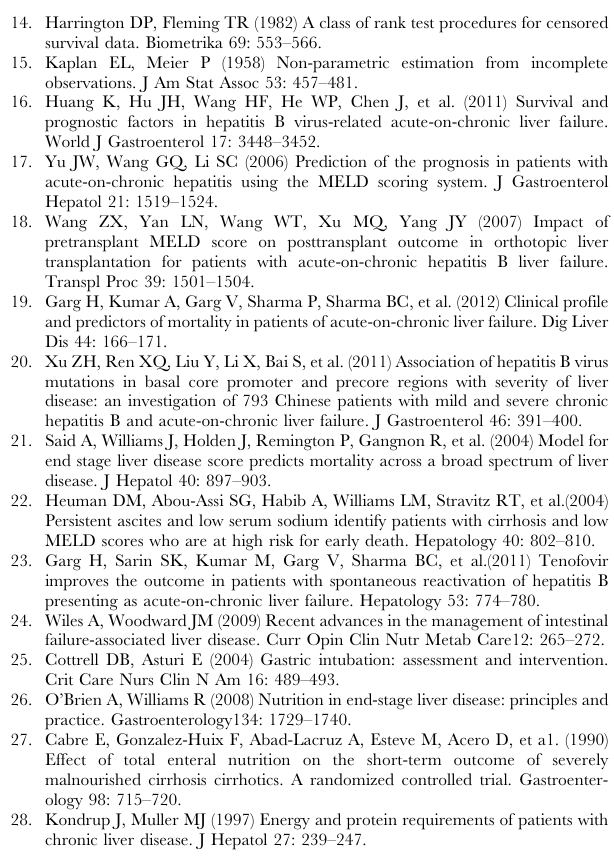
Table S1 Baseline characteristics of patients with ACLF and pre-ACLF. Abbreviations: Abbreviation: ACLF, acute-to- chronic liver failure; INR, international normalized ratio; CTP, Child–Turcotte–Pugh scoring system; MELD, model for end-stage liver disease scoring system Normal distribution continuous values